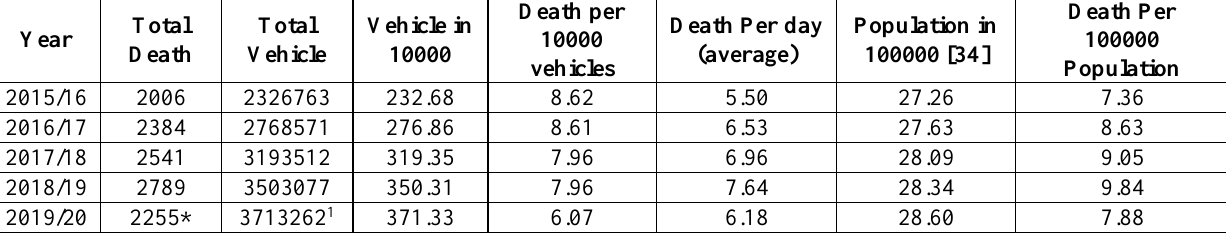
Table 31: Analysis of fatality with respect to Vehicle and